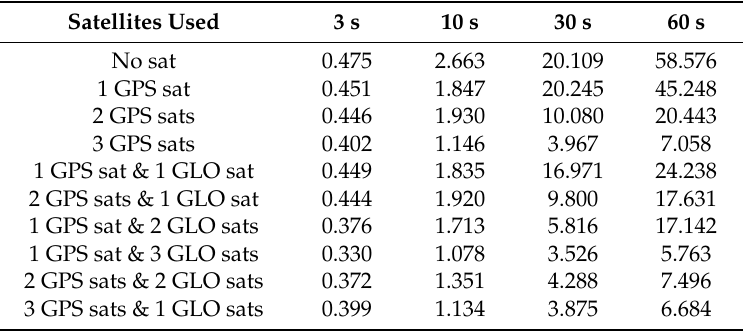
Table 4. 3D position errors at short times for the second dataset (unit: meter).